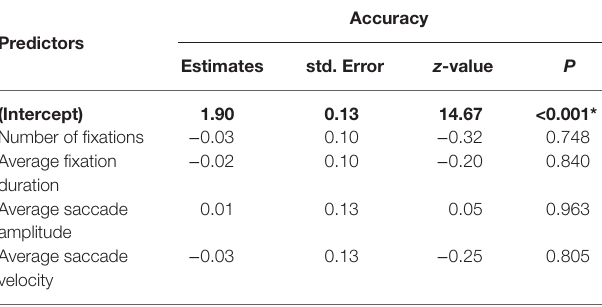
TABLE 4 | Generalised linear mixed effect (GLME) model for gaze parameters and trial